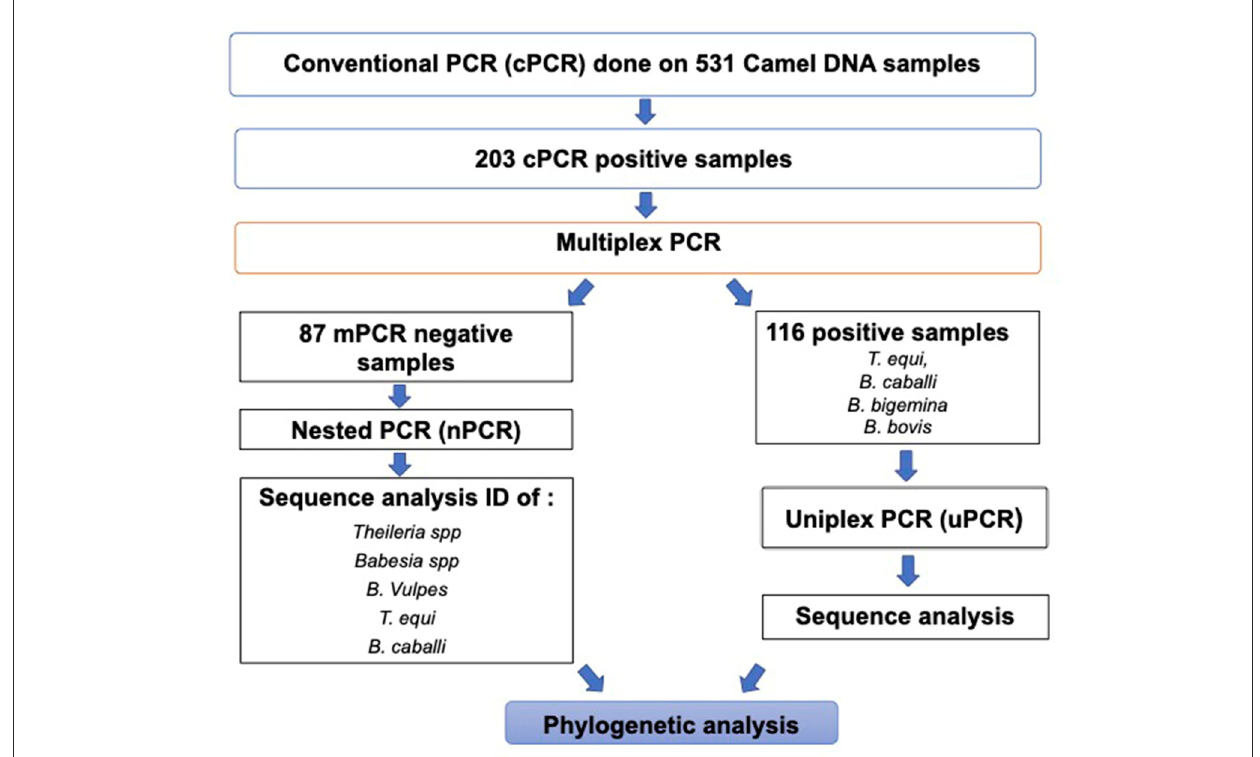
FIGURE4 Workflow chart describing the molecular diagnostic procedures and a summary of the molecular diagnostic data in this study.